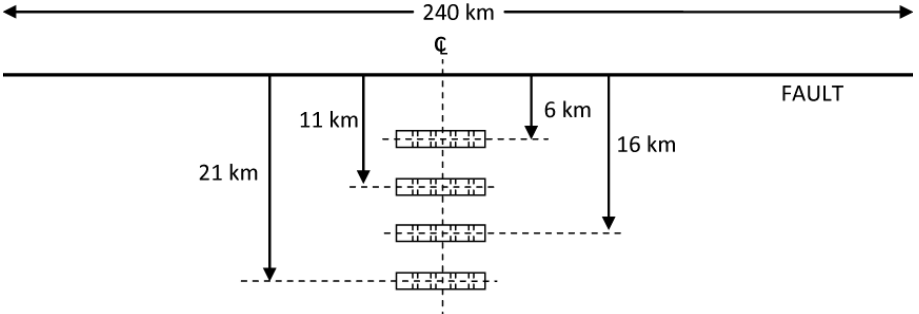
Figure 7. Fault geometry and bridge locations used in the